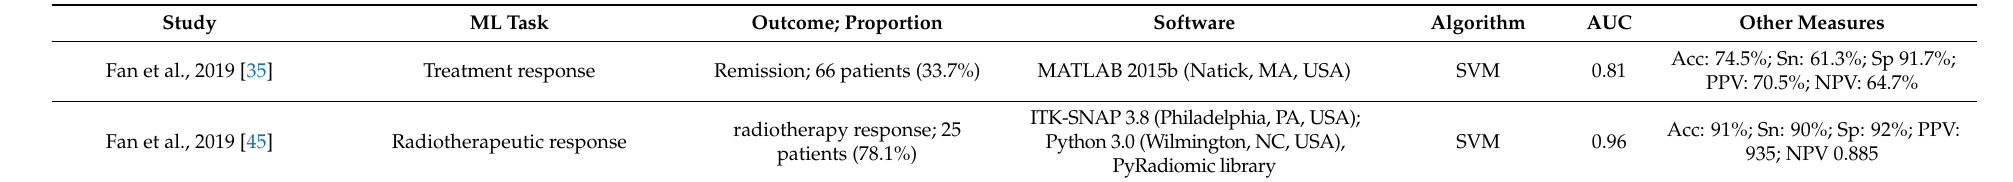
Table 4. Machine learning models